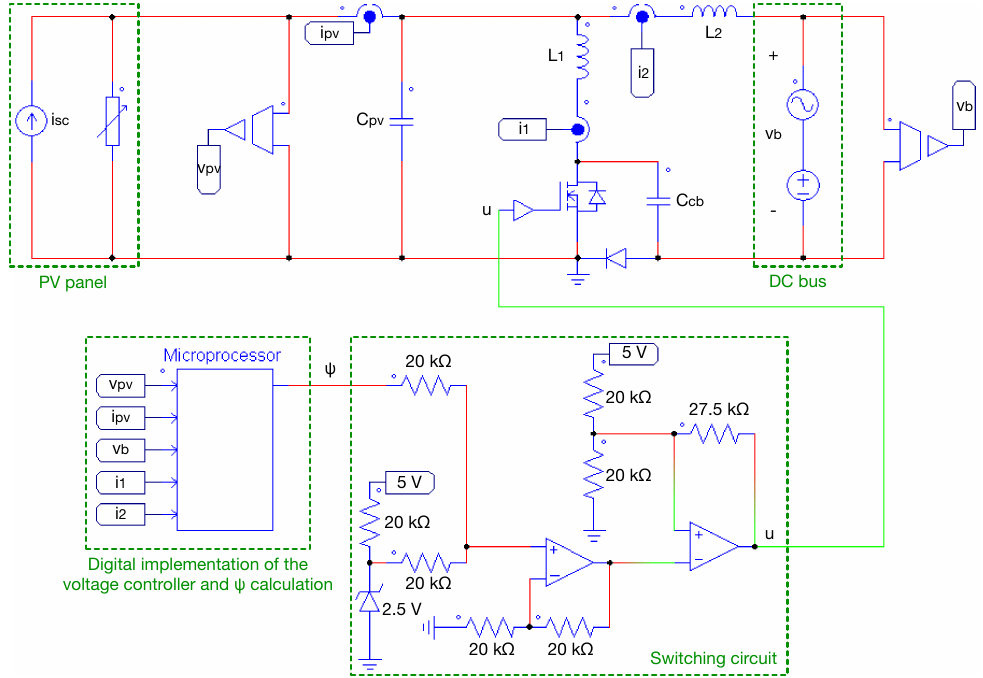
Figure 14. PV system circuit implemented in